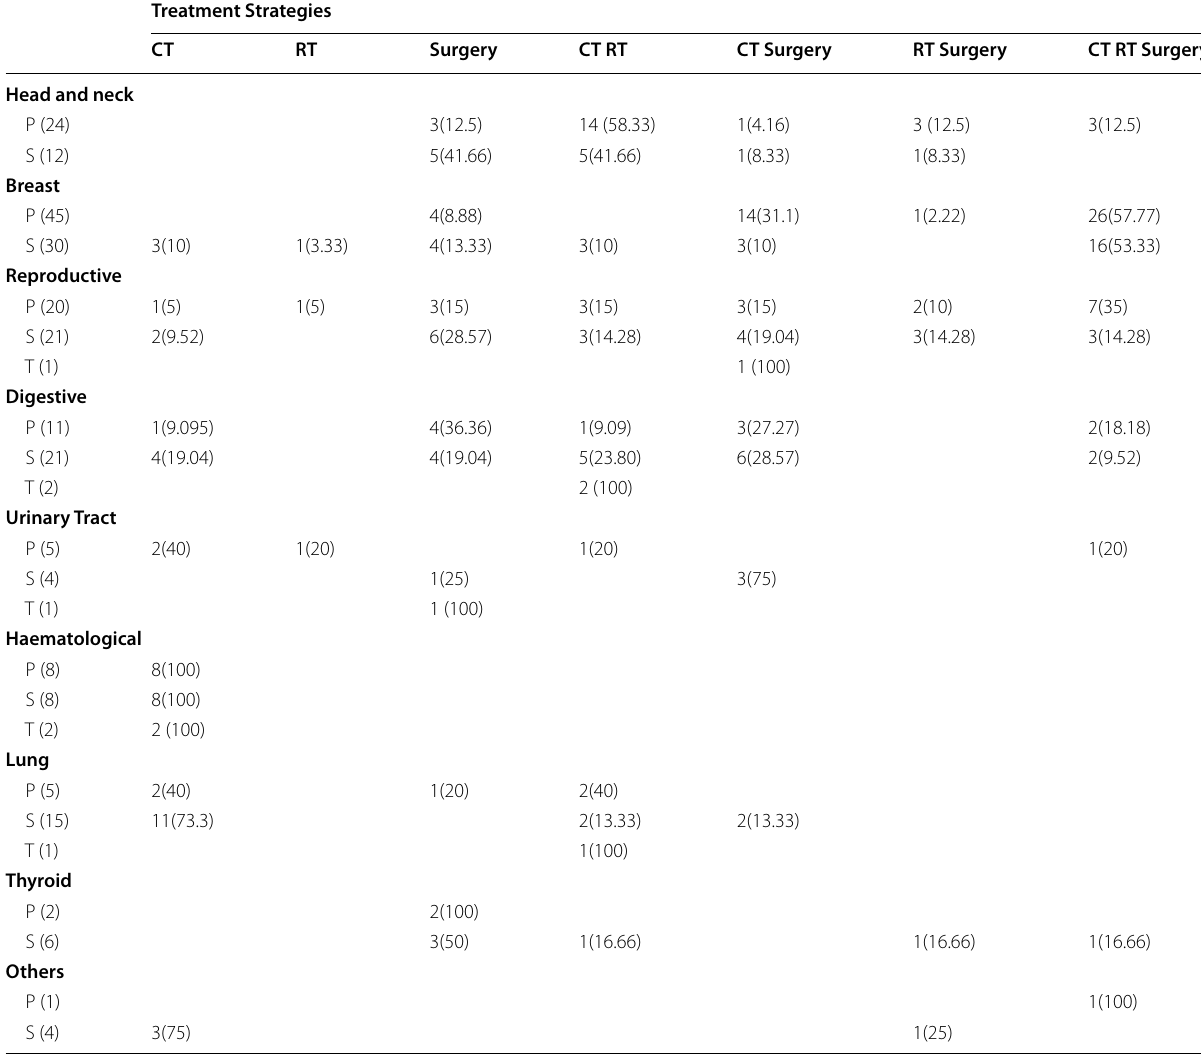
P First Primary, S Second Primary, T Third Primary, CT Chemotherapy, RT Radiotherapy * Values in the bracket indicates percentage of patients received various therapies